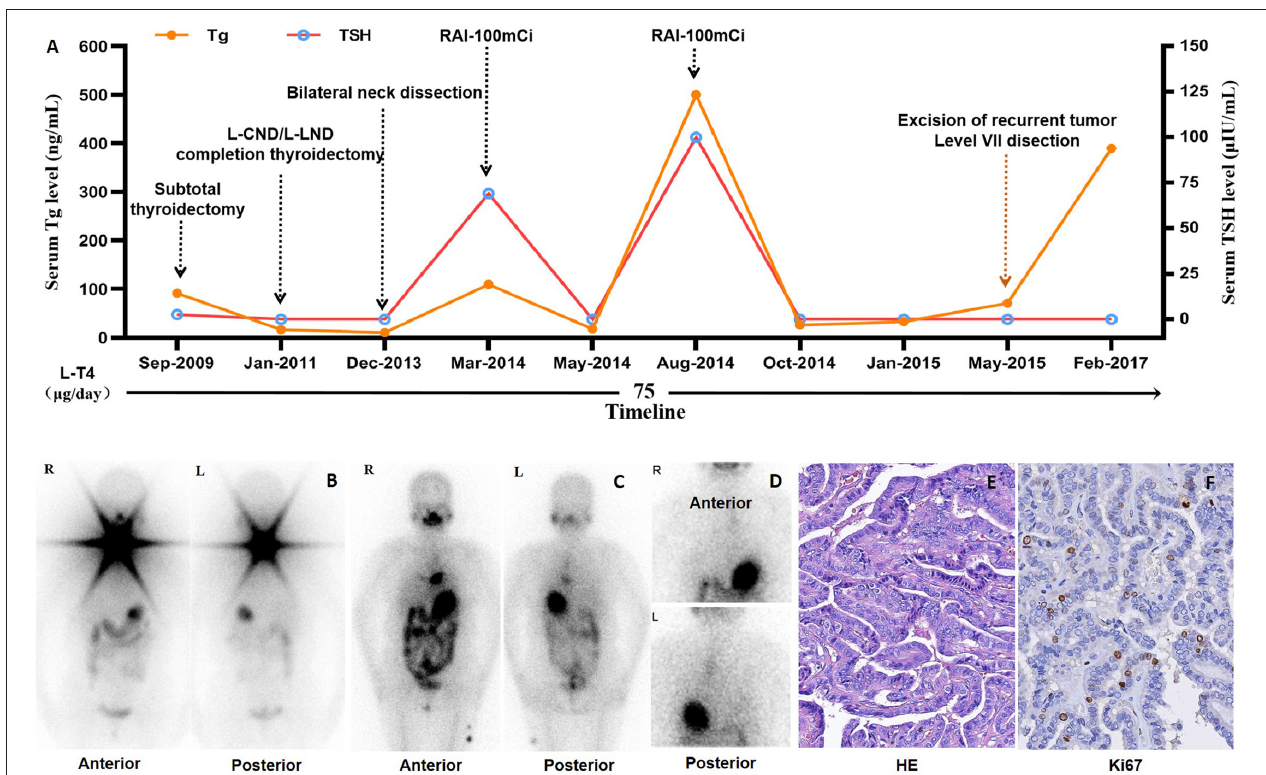
FIGURE 1 | Treatment prior to anlotinib therapy. (A) Timeline of treatment prior to clinical study, including four operations in the neck, two sessions of RAI therapy and TSH suppression therapy with L-T4. (B) Functional iodine uptake was observed in the neck on the initial post-treatment whole-body scan. (C) No functional iodine uptake was observed in the neck on the second post-therapy whole-body scan, but an abnormal radioactive iodine uptake foci in anterior-inferior mediastinum. (D) Abnormal radioactive iodine uptake foci in anterior-inferior mediastinum was confirmed to be external contamination by change clothes. (E) Papillary thyroid carcinoma was confirmed pathologically with specimen from the 4th operation (HE stain, x200) after RAIR-DTC was developed, and Ki67 stain revealed about 10% positive rate. Tg, Thyroglobulin; TSH, Thyroid Stimulating Hormone; L-CND, Left-Central Neck Dissection; L-LND, Left-Lateral Neck Dissection; RAI, Radioactive